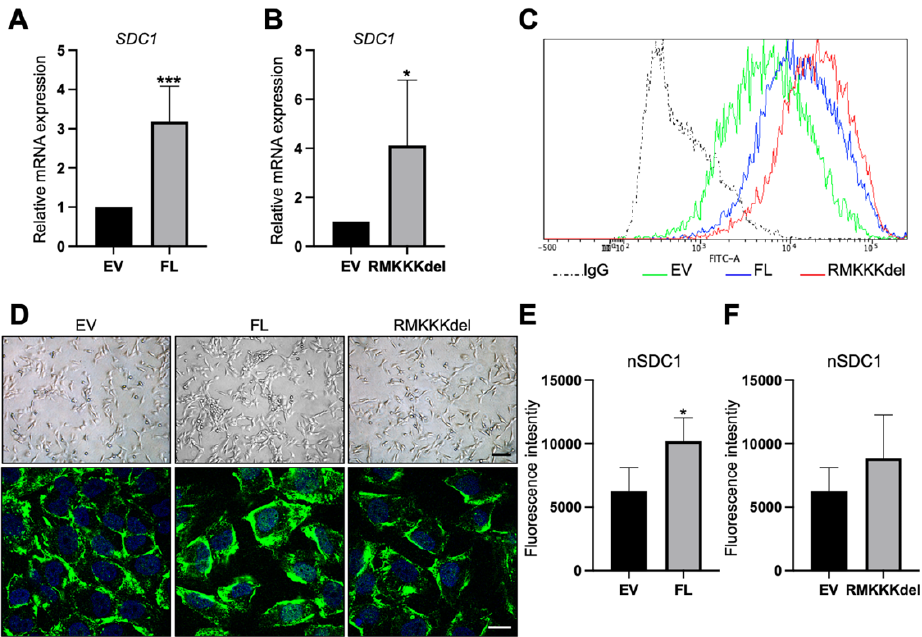
Figure 5. Overexpression of SDC1 in B6FS fibrosarcoma cells. ( A , B ) Bar graphs showing results from qPCR analysis of SDC1 mRNA levels in B6FS cells transfected with full length SDC1 (FL, A ) or a mutant SDC1 lacking the nuclear localization signal RMKKK (RMKKKdel, B ) compared to B6FS cells transfected with an empty vector (EV). ( C ) Histogram showing cell surface levels of SDC1 in B6FS cells as detected by fluorescence activated cell sorting (FACS) analysis. Dotted line represents the results obtained with an unspecific IgG antibody, which was used as a negative control. Solid lines show the cell surface levels of SDC1 in cells stably overexpressing the empty vector (EV, green), FL SDC1 (FL, blue), or the SDC1 mutant (RMKKKdel, red). ( D ) Upper panels: Brightfield images showing the morphology of B6FS cells transfected with the empty vector (EV), FL SDC1, or the RMKKKdel mutant. Lower panels: Images showing immunofluorescent staining of SDC1 (green) in B6FS EV, FL, and RMKKKdel cells. Scale bars = 30 µ m (upper); 5 µ m (lower). ( E , F ) Bar graphs showing quantification of nuclear SDC1 in confocal microscopy images of B6FS cells transfected with FL SDC1 ( E ) or the RMKKKdel mutant ( F ) compared to the control cells. * = p < 0.05; *** = p < 0.001. Based on the results from the A549 cells, we analyzed whether overexpression of SDC1 would affect EMT markers in B6FS cells. Immunofluorescent analysis revealed in- tense nuclear staining of ZEB1 in the control B6FS cells (Figure 6A). In comparison, re- duced nuclear ZEB1 intensity was observed in BSFS cells overexpressing FL SDC1, but not in cells overexpressing the RMKKKdel mutant (Figure 6A,B). Western blot analysis showed that E-cadherin levels were undetectable in control B6FS cells, and this did not change after overexpression of FL SDC1 or the RMKKKdel mutant (Supplementary Figure S3A). In contrast, N-cadherin levels were significantly reduced in B6FS cells overexpress- ing either the FL SDC1 or the RMKKKdel mutant compared to the control cells (Figure 6C and Supplementary Figure S3B). Vimentin levels were significantly reduced in B6FS cells overexpressing FL SDC1, and showed a tendency to also be repressed in B6FS cells over- expressing the RMKKKdel mutant, but this was not statistically significant (Figure 6D and Supplementary Figure S2C).